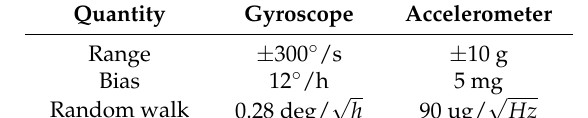
Table 2. Specifications of the SINS.